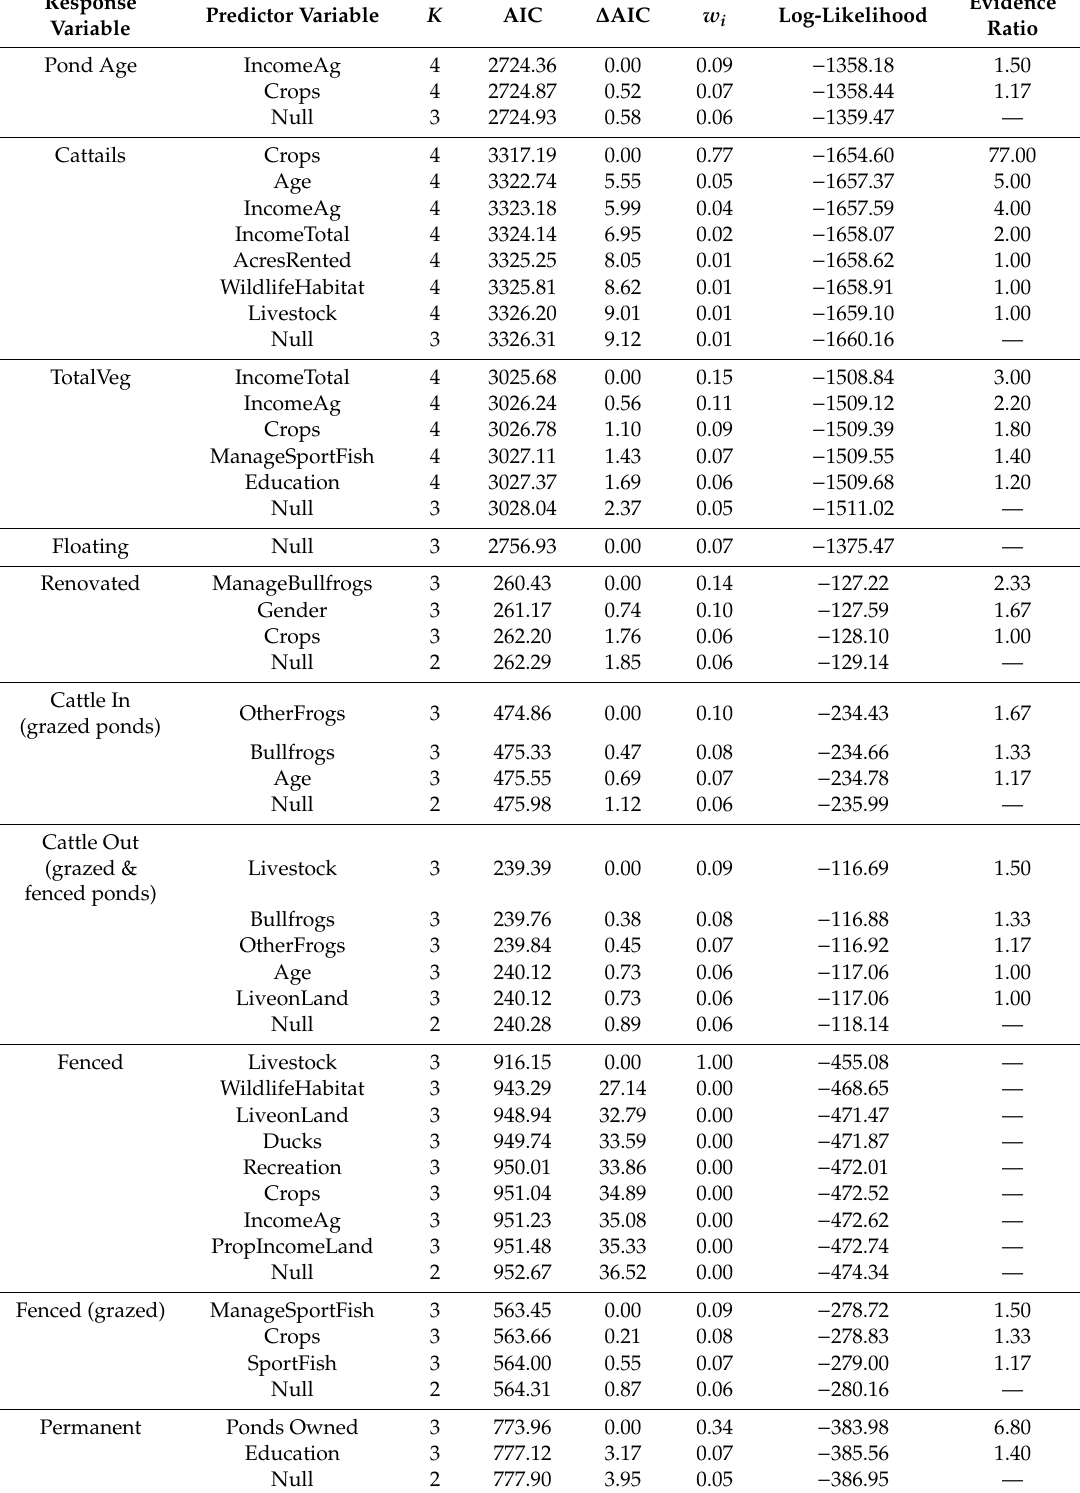
Table 3. Model selection results from general / generalized linear regression for nine response variables (see Table 1 for descriptions). Only models ranking better than the null model (based on ∆ AIC) are shown. ∆ AIC = the di ff erence between the top model and a competing model; w i = Akaike weight, interpreted as the probability that the given model is the best-approximating model of the candidate set; K = the number of estimable parameters in the model, including the intercept; Evidence ratio = an indication of the relative support for a given model compared with the null model, w i / w Null